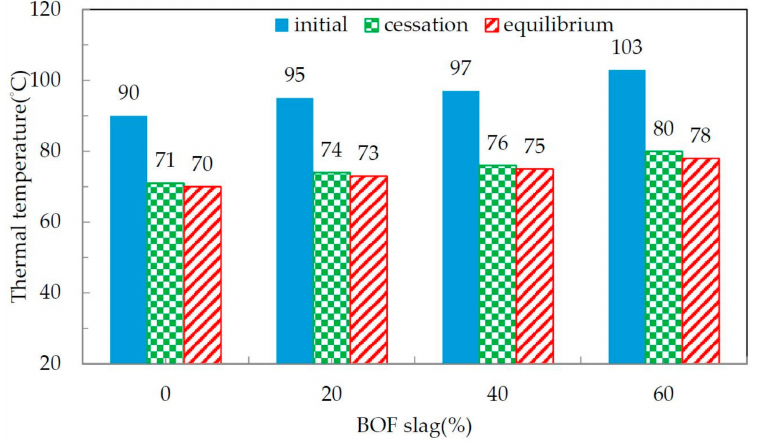
Figure 7. Relationship between the temperature intervals and the BOF slag contents